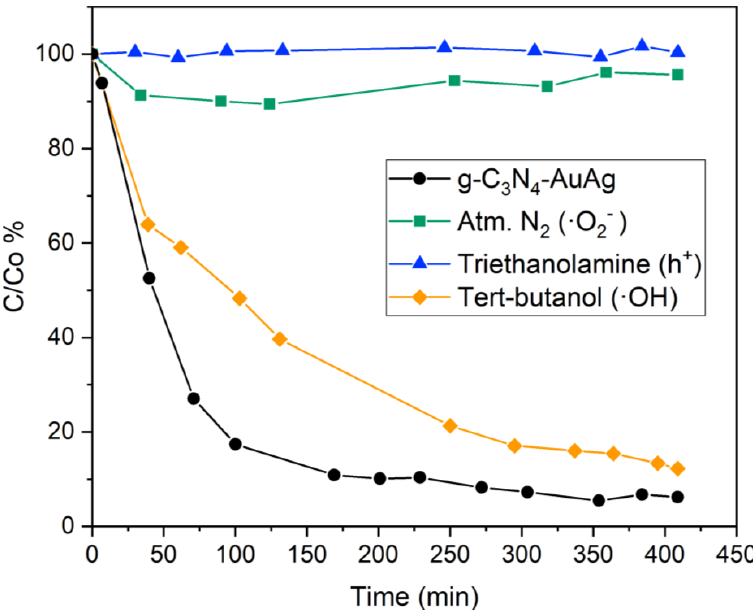
Figure 10. Evolution of ibuprofen concentration during photocatalytic degradation with 3 under visible light irradiation and effect of scavengers.